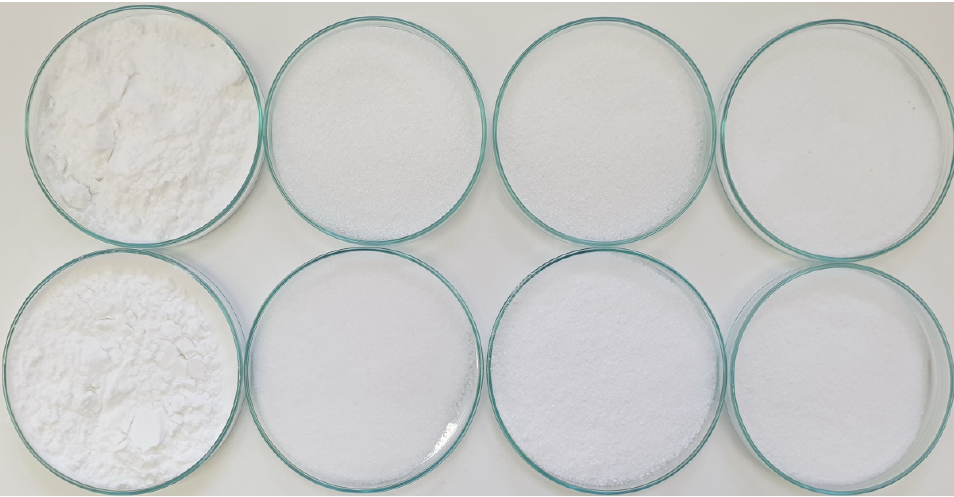
Figure 5. Photograph of raw material and obtained aerogel samples (from left: native starch, aerogel, E 1422 aerogel, and E1450 aerogel; from top: native and waxy variety, respectively).